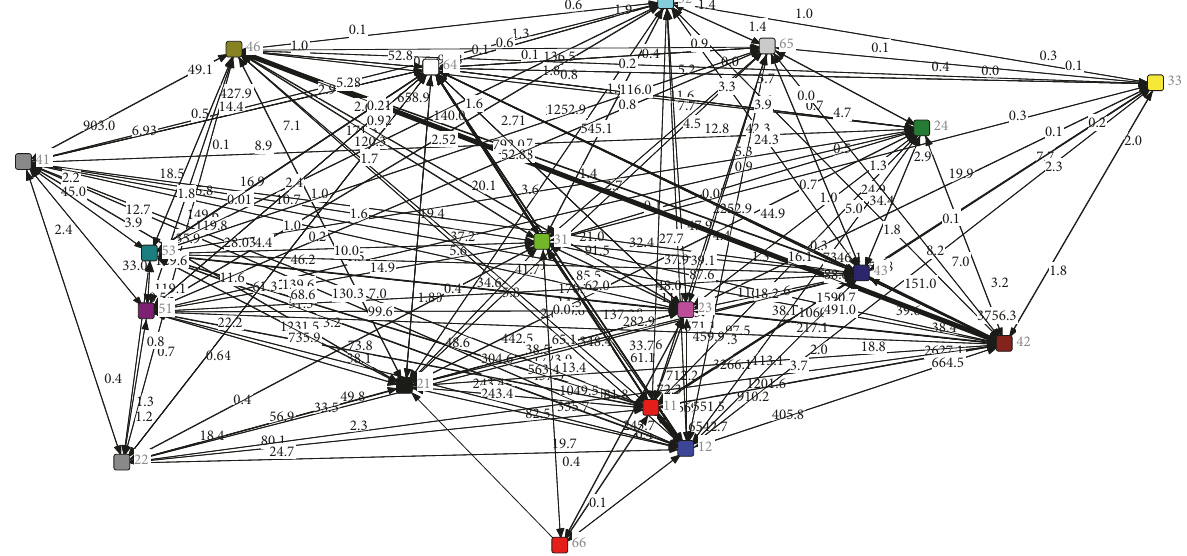
Figure 9: The topology of land system networks showing the conversions among land cover types in